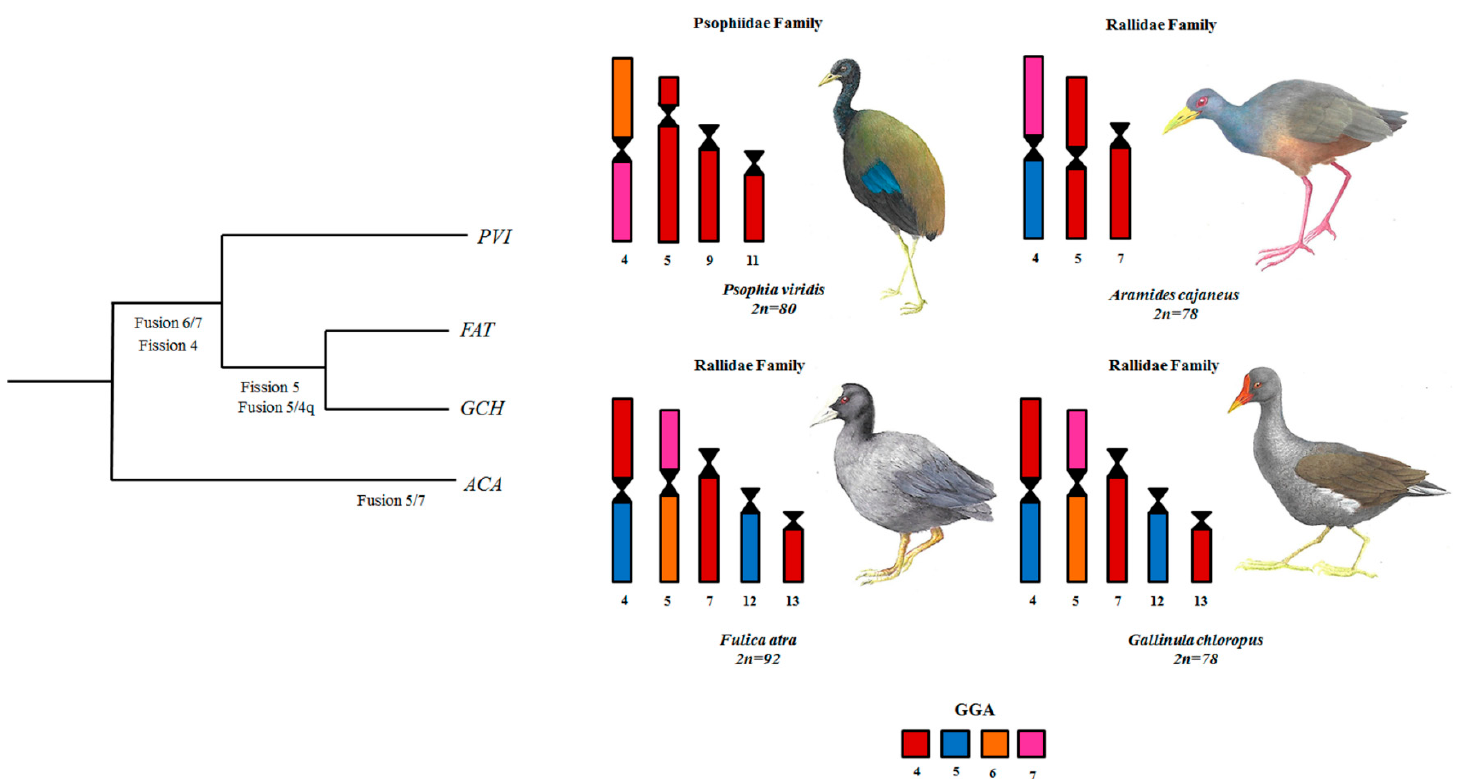
Figure 5. Schematic representation of chromosome rearrangements during evolution of the Gruiformes based on comparative chromosome painting and literature results (Nanda et al., 2011). We propose that the A. cajaneus would be more basal within the Rallidae family and P. viridis close to F. atra and G. chloropus . Legend: Fulica atra (FAT), Aramides cajaneus (ACA), Gallinula chloropus (GCH), Psophia viridis (PVI), Gallus gallus (GGA). 227